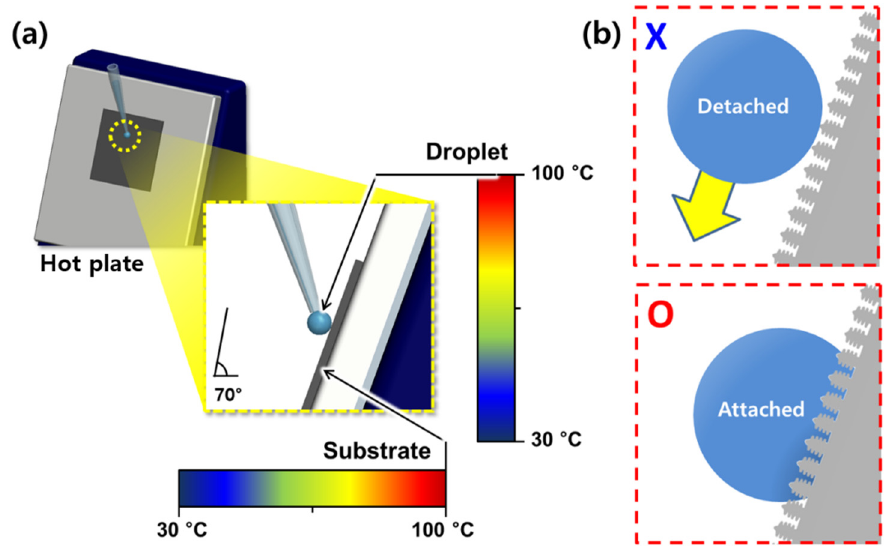
Figure 1. ( a ) Experimental setup for obtaining DB maps. ( b ) Illustrative diagrams of detached (X) and attached (O) droplets on a fluorinated micro/nanostructured titanium surface.